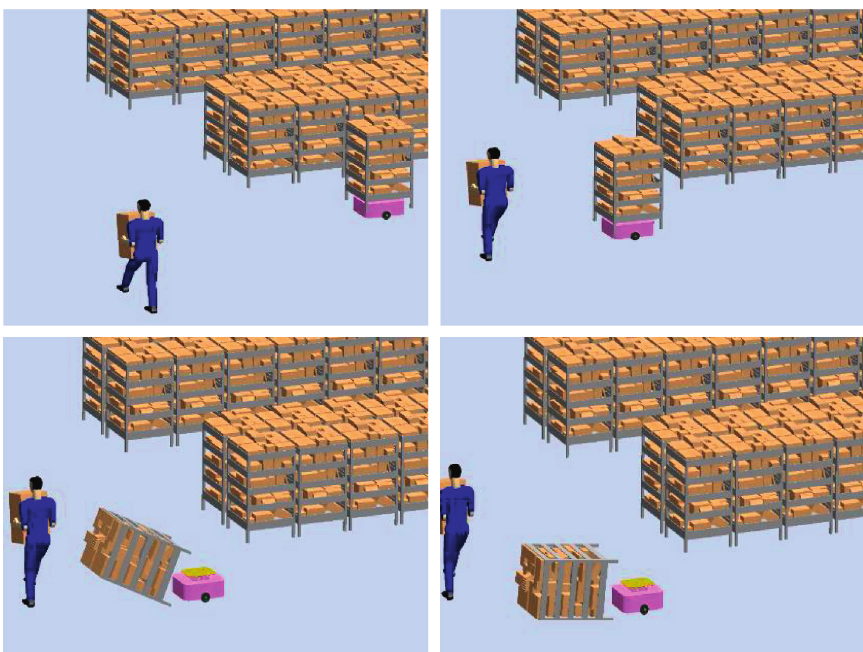
Figure 2: Simulation of physical collision between human and robot sharing the same workspace (see in